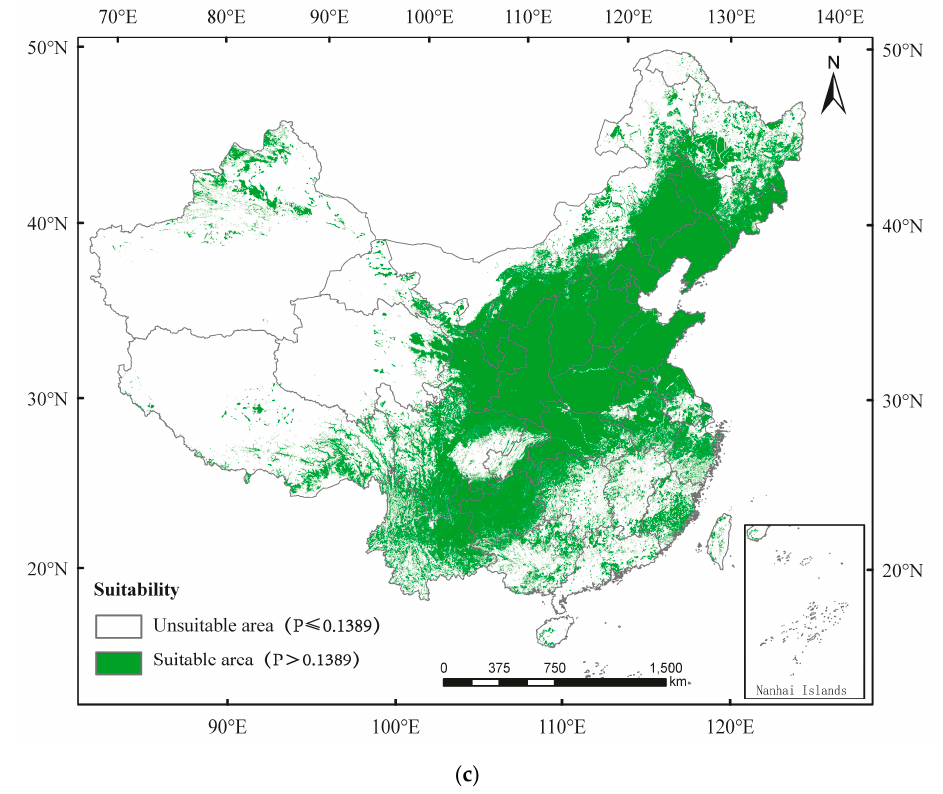
Figure 4. Potential distribution of Dendrocopos major in China predicted using the MaxEnt model under ( a ) the current climate and according to climate change in ( b ) 2050 and ( c ) 2090. 3.3. Spatial Transfer Characteristics of Suitable Areas for A. glabripennis, D. helophoroides, and D.